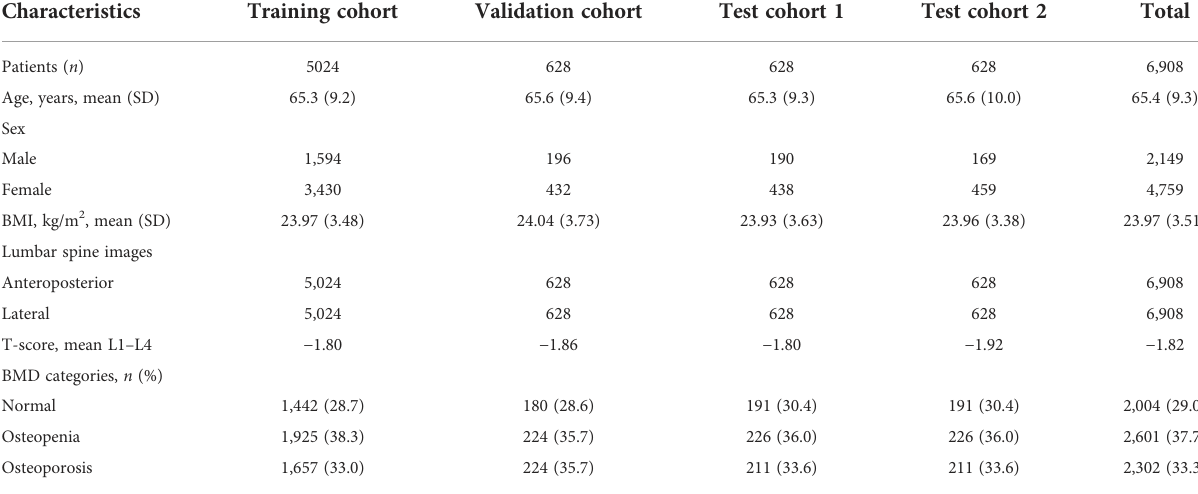
TABLE 1 Demographic characteristics of 6,908